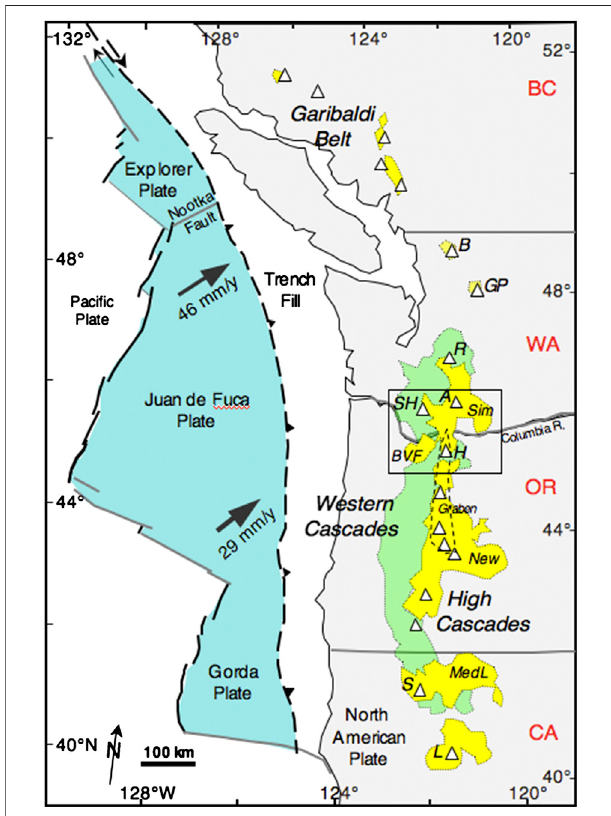
FIGURE 3 | General tectonic setting of the Cascade volcanic arc that spans from British Columbia through Washington and Oregon to northern California (after Mullen et al., 2017). Triangles indicate locations of prominent Quaternary stratovolcanoes; selected ones are identi fi ed as Mts. Baker (B), Glacier Peak (GP), Rainier (R), St. Helens (SH), Adams (A), Hood (H), Shasta (S), and Lassen (L). Large backarc volcanic fi elds are identi fi ed as Simcoe (Sim), Newberry (New), and Medicine Lake (MedL). Dashed fi eld in Oregon is the High Cascades central graben. Also shown are general distributions of Pliocene-Recent High Cascades (yellow fi eld) and Eocene- Miocene Western Cascades (green fi eld) volcanic rocks (cf. Luedke and Smith, 1982). Large arrows show azimuth and velocity of subducting oceanic plates (dark green fi eld) relative to North America. Selected inset rectangle is expanded in Figure 4